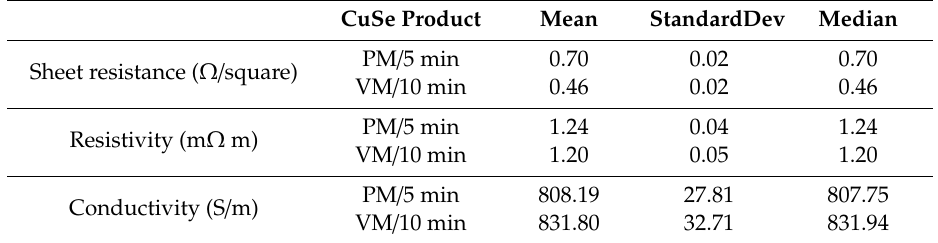
Table 4. Electrical properties of CuSe products synthesized in planetary (PM) and vibratory (VM) mills. CuSe Product Mean StandardDev Sheet resistance ( Ω /